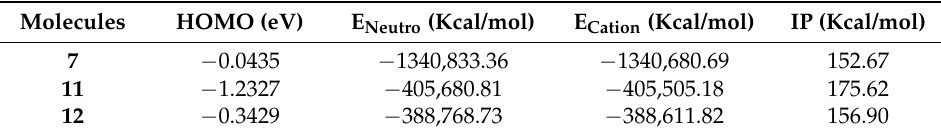
Table 2. Theoretical Properties obtained for the compounds studied.